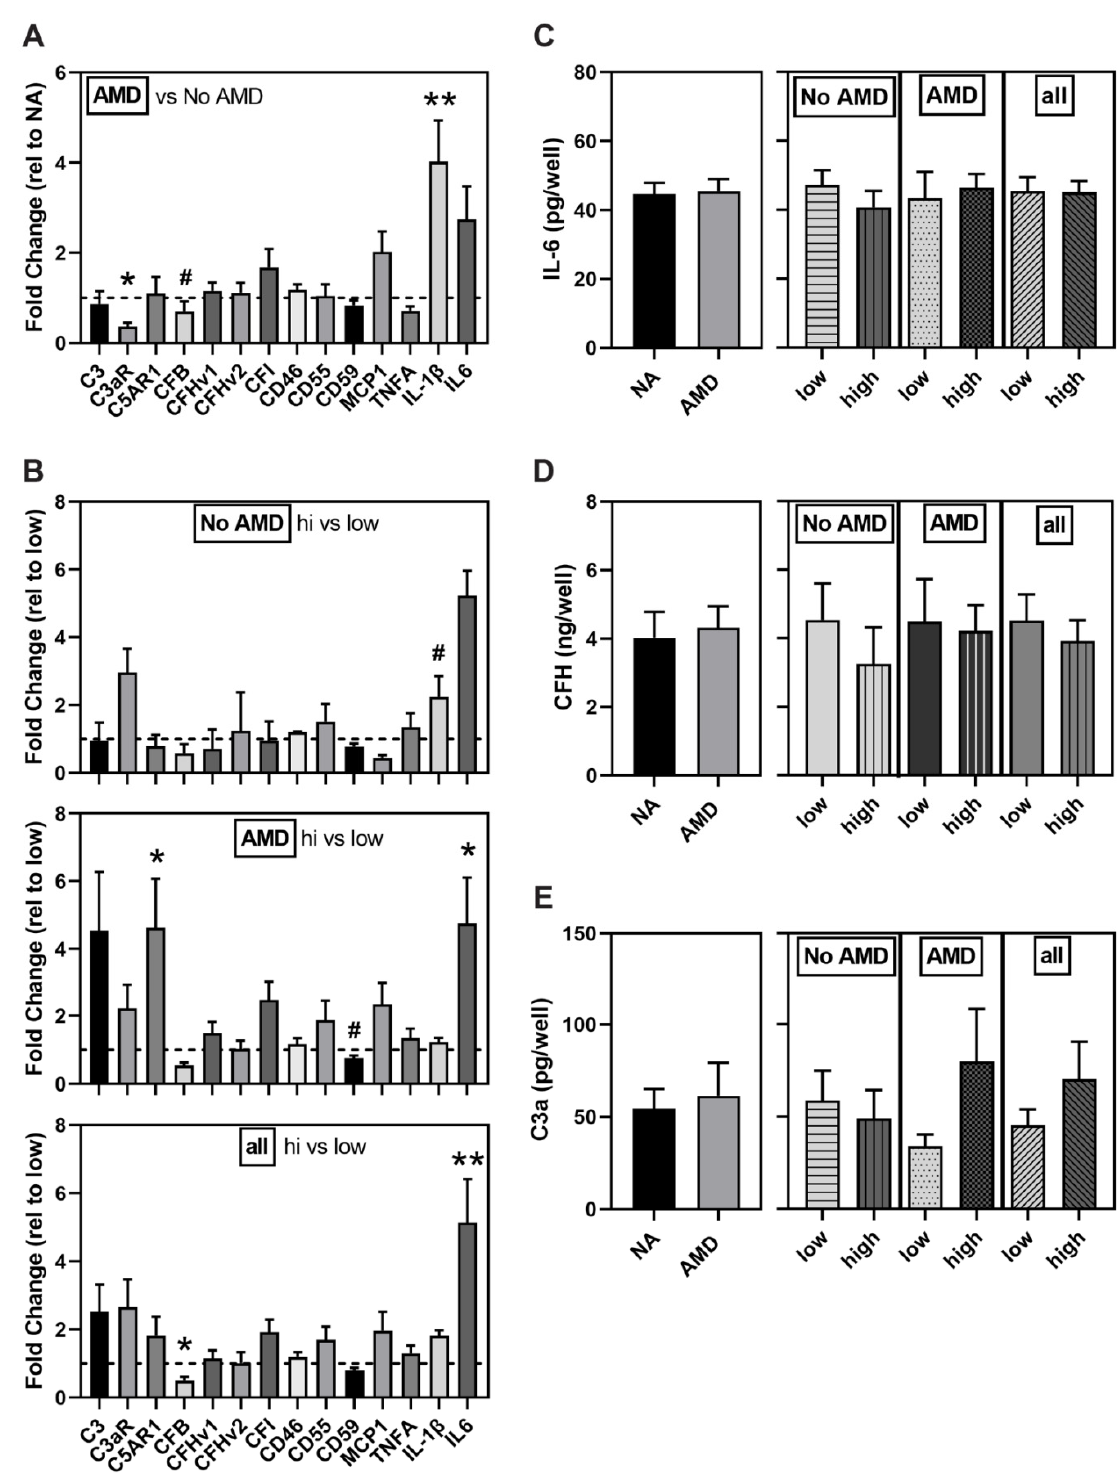
Figure 5. Altered markers of inflammation and complement components in AMD and high-risk iPSC-RPE. ( A , B ) Gene expression analysis of complement-related genes in iPSC-RPE from ( A ) No AMD (5 donors, 8 lines) and AMD (13 donors, 20 lines) donors or ( B ) CFH low-risk (No AMD n = 3 donors, 5 lines; AMD n = 5 donors, 8 lines) and high-risk (No AMD n = 1 donor, 2 lines; AMD n = 8 donors, 12 lines). Results shown are fold-change in expression of ( A ) AMD relative to the average of No AMD samples (dashed line) or ( B ) high-risk relative to the average of low-risk donors (dashed line). ELISA for IL-6 ( C ), CFH ( D ), and C3a ( E ) in media from iPSC-RPE comparing No AMD (7 donors, 10 lines) and AMD (12 donors, 17 lines) donors or low risk (No AMD 4 donors, 6 lines; AMD 4 donors, 5 lines) and high risk (No AMD 3 donors, 4 lines; AMD 9 donors, 13 lines) donors. NA = No AMD. All data are mean ± SEM. ** p < 0.01, * p < 0.05, # p < 0.1 determined by un-paired t-tests. All other comparisons were not statistically different.